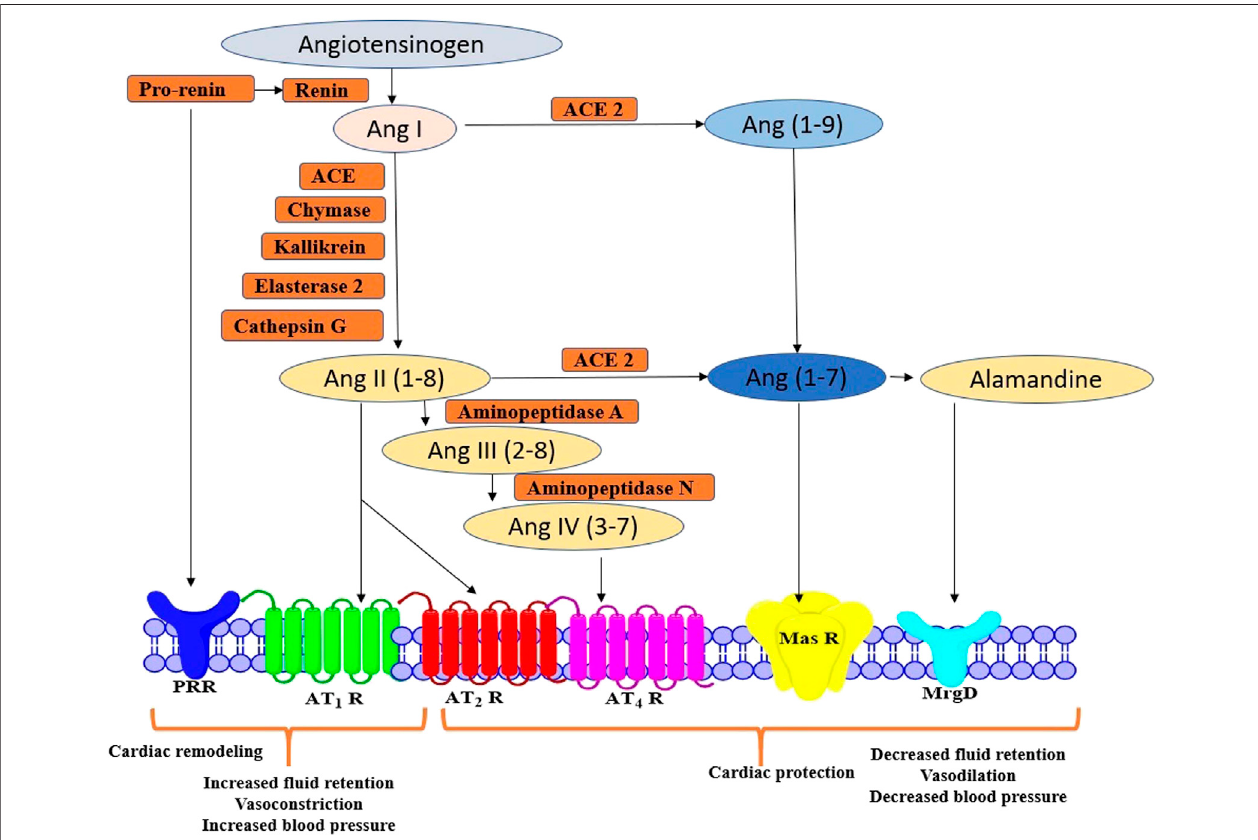
FIGURE1| SchematicrepresentationofAngIIpeptidesandreceptorsinRASsignallingpathwayAT 1 R,AngiotensinIIType1Receptor;AT 2 R,AngiotensinIIType 2Receptor;ANGII,angiotensinII;Ang-(1 – 7),Angiotensin-(1 – 7);Ang-(1 – 9),Angiotensin-(1 – 9);ACE2,Angiotensin-convertingEnzyme2;MasR,Mitochondrialassembly protein